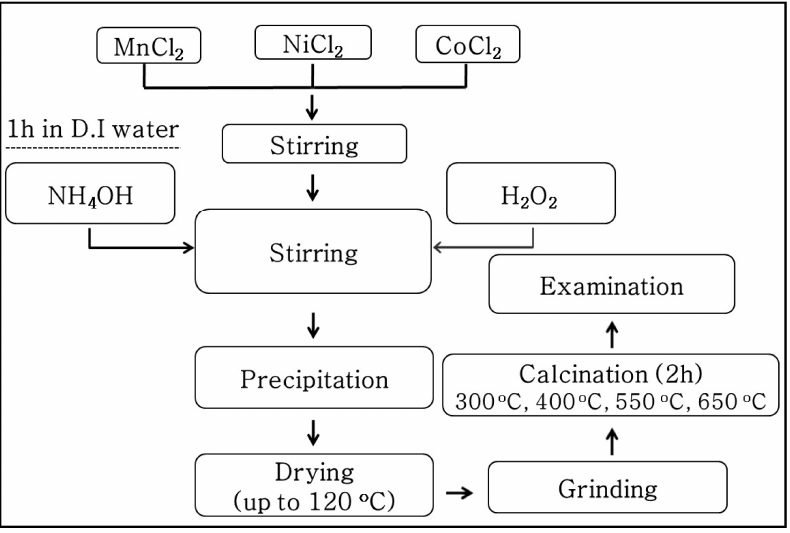
Figure 1. Flowchart for Mn–Ni–Co–O powder preparation from a chloride solution.